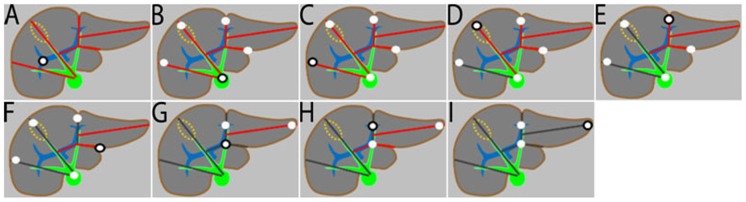
Semi-automated Interactive Software for CT-volumetry (P) – Manual Positioning of 9 Anatomical Landmarks to Define the Segments of Couinaud (Schematic Illustration; Courtesy of Philips Healthcare Germany, Hamburg, Germany).A first bifurcation of the right portal vein (black circle). B inferior caval vein (black circle). C right hepatic vein (black circle). D middle hepatic vein (black circle). E left hepatic vein (black circle). F superficial ligamentum venosum (black circle). G deep ligamentum venosum (black circle). H end of left portal vein (black circle). I left liver tip (black circle) Note: after automated outline of the entire liver with correction of false-positive and false-negative extractions, and then after manual positioning of the 9 anatomical landmarks, volumes of transplanted liver segments are obtained.